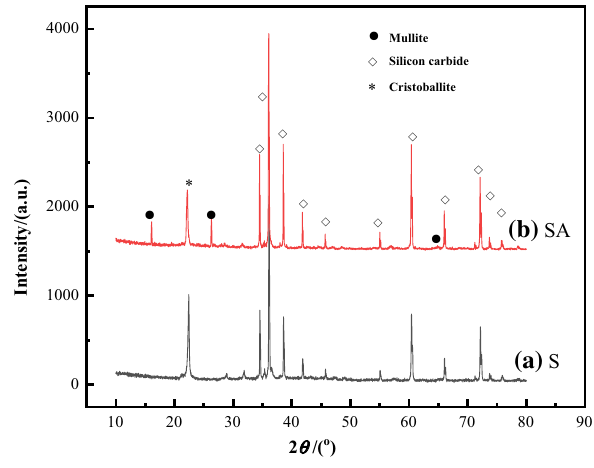
Fig. 4 XRD patterns of the specimens sintered at 1500 °C for 2 h in the